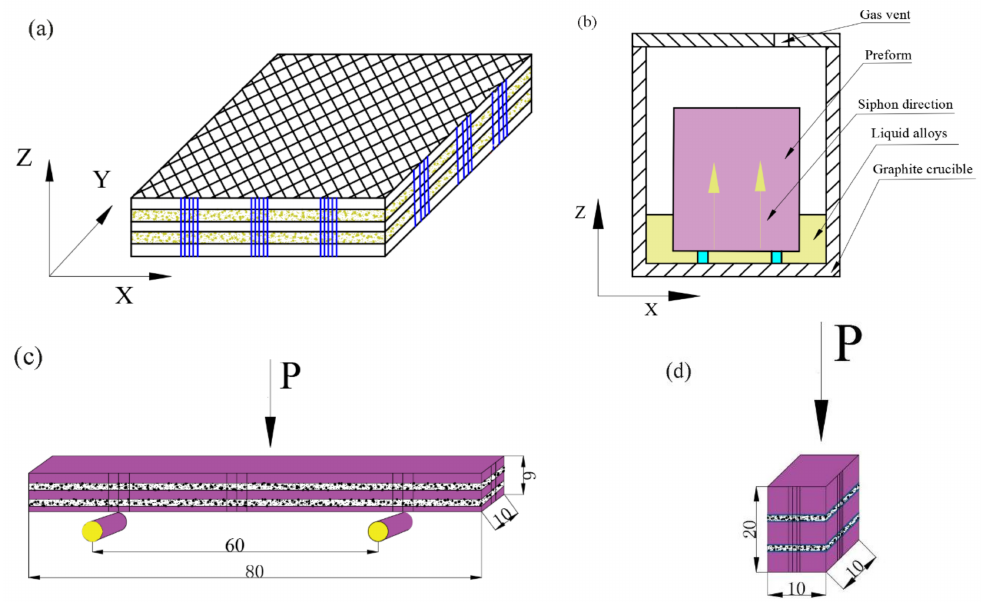
Figure 1. Schematic of the preform, siphon tooling mold, and test diagrams. ( a ) Schematic of 2.5D-polyacrylonitrile-based carbon fiber felts; ( b ) schematic view of the siphon tooling mold; ( c ) three-point bending diagram; and ( d ) the compression